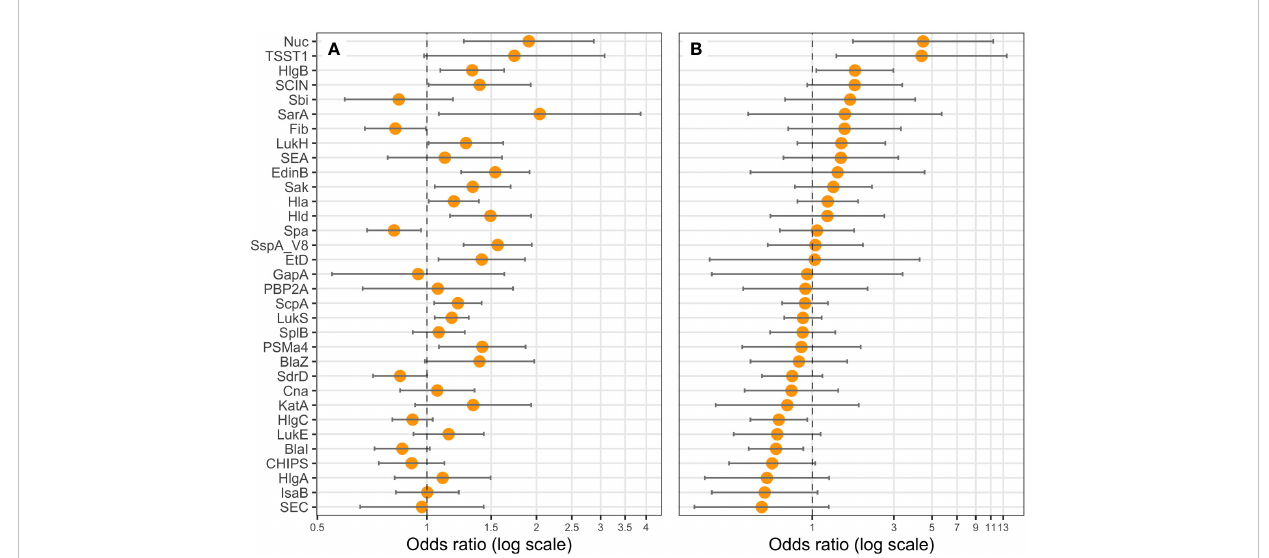
FIGURE 6 Nuc, TSST-1, HlgC, and BlaI expression are correlated with leukopenia. Logistic regression models including the Charlson Comorbidity Index score as covariate were performed, with either (A) one protein (univariate), or (B) all proteins (multivariate) as explicative variables, and leukopenia (<3G/L) as the response variable. Coef fi cients were reported as odds ratios (orange dots) with 95% con fi dence intervals (error bars). LukF-PV from LukSF-PV, LukG from LukGH, PSM a 1 from PSM a 1-4, and LukD from LukDE were removed from the statistical analysis to account for multi-collinearity.